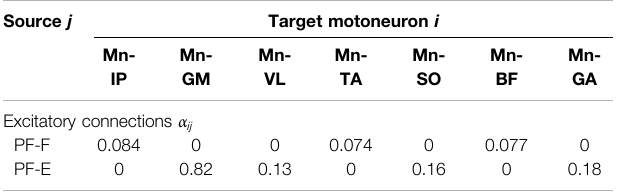
TABLE 2 | Parameters for currents. TABLE 3 | Optimized parameters for synaptic